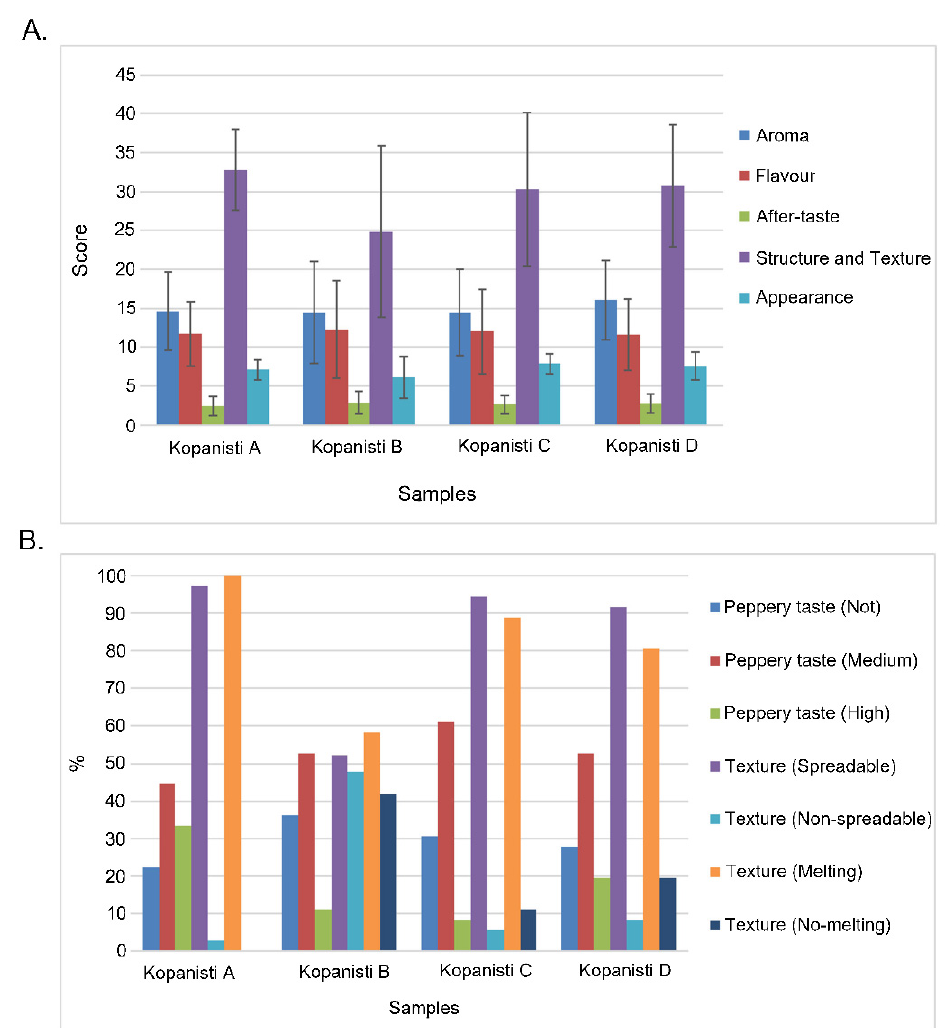
Figure 8. Graphical representation of sensory evaluation of Kopanisti A, B, C and D cheese samples on Day 35 regarding ( A ) aroma, flavour, after-taste, structure and texture and appearance, and ( B ) peppery taste (not/medium/high), texture (spreadable/non-spreadable) and texture (melting/no- melting). Statistically significant differences ( p < 0.05) were detected between Kopanisti A and B, Kopanisti B and C, and Kopanisti B and D for structure and texture, and between Kopanisti B and C, and Kopanisti B and D for appearance.